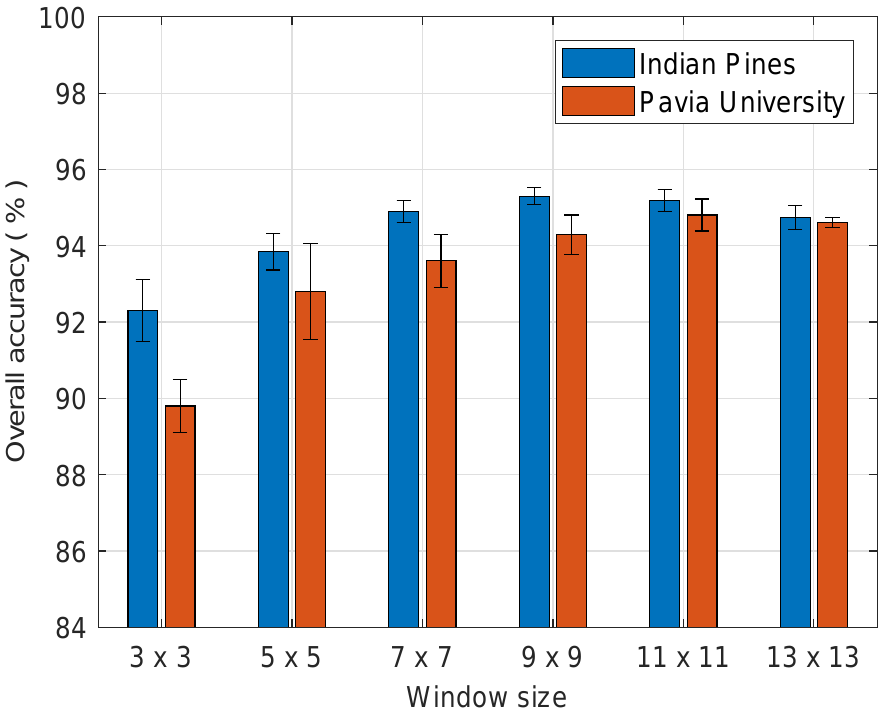
Figure 4. Parameter analysis of window size for two datasets.